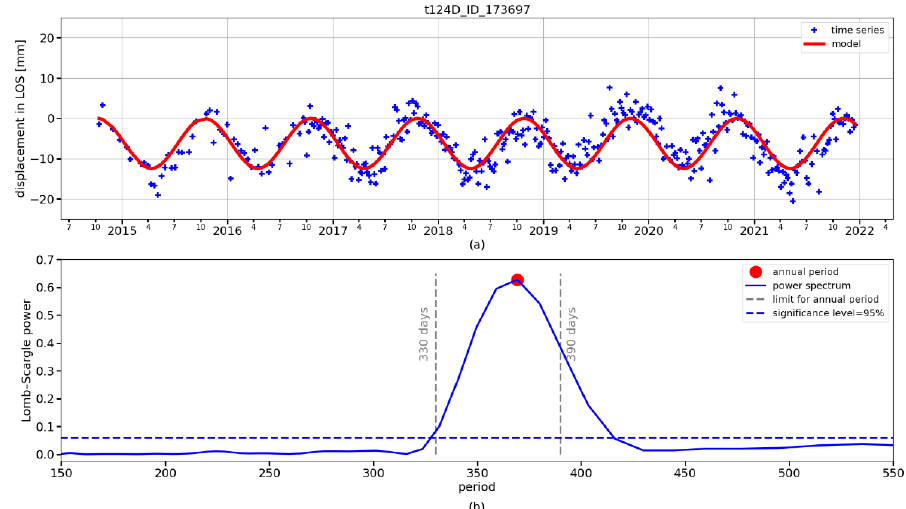
Figure 7. Time series of PS point 173,697 (track D124) displacement in LOS and model based on periodogram ( a ) and corresponding Lomb – Scargle periodogram ( b ). The significant periodicity of the point was identified with a period of around 380 days.